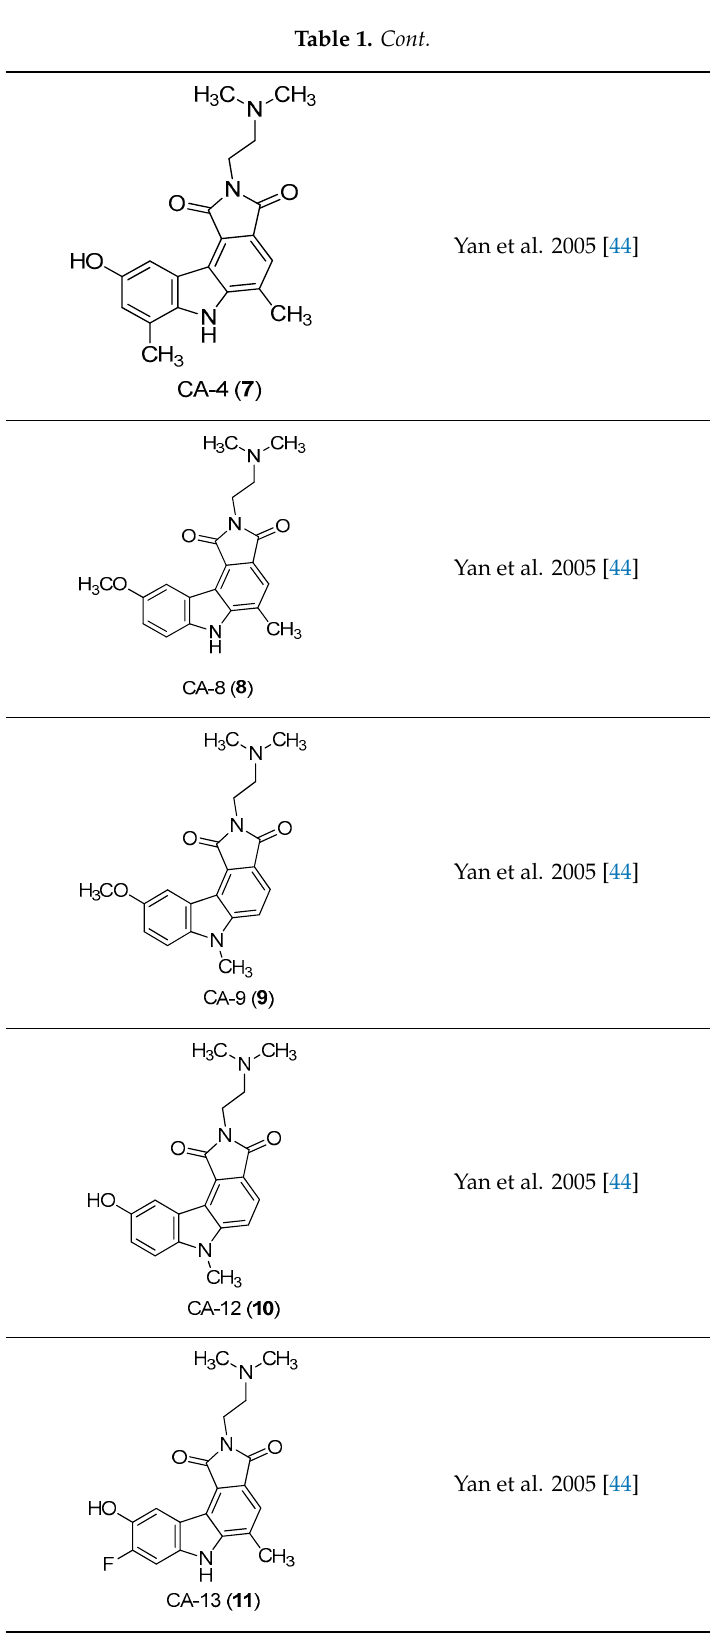
Molecules 2019 , 24 ,